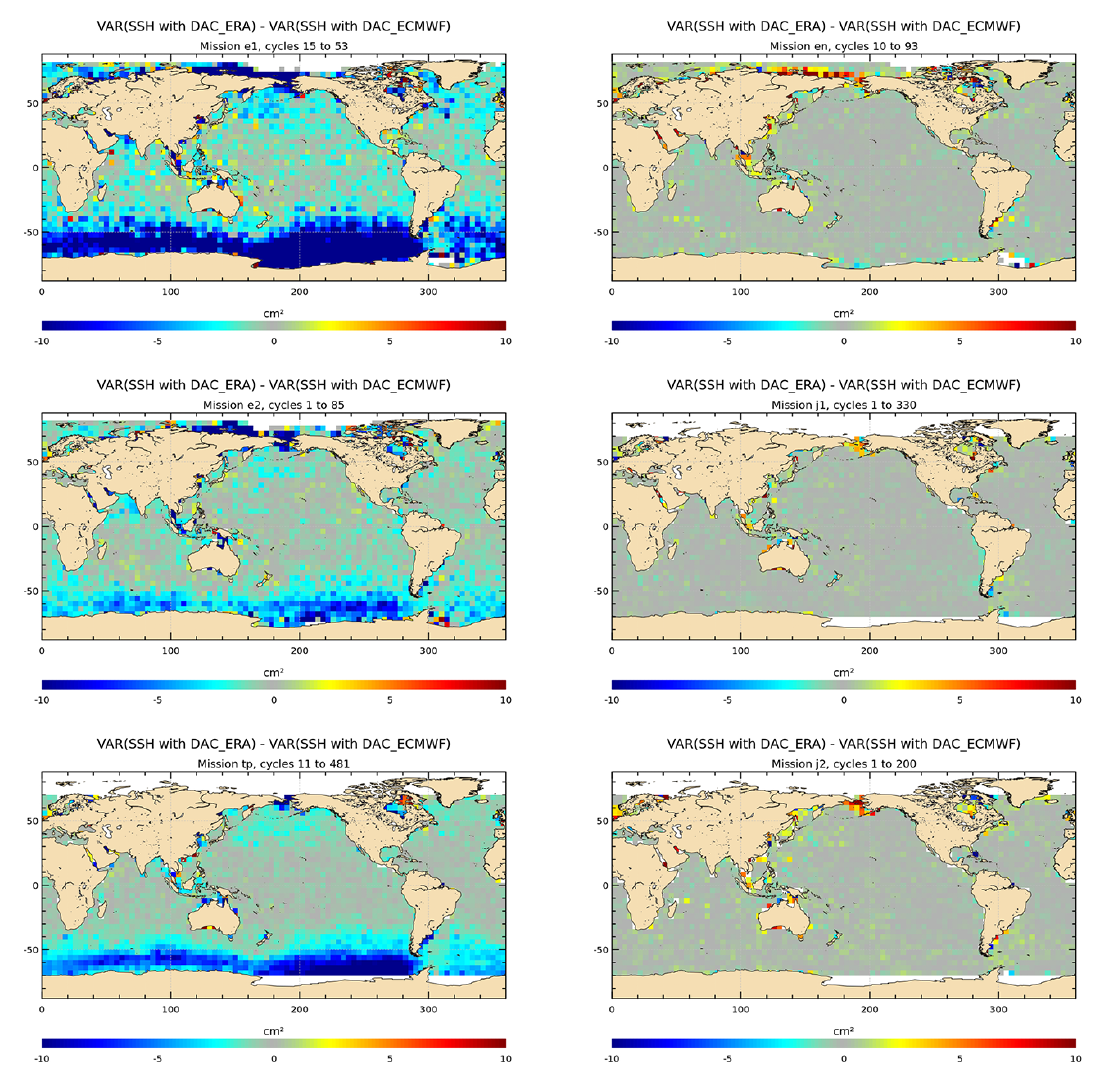
Figure 8. Maps of SSH variance differences at crossovers successively using the ERA-Interim and reference DAC solutions in the SSH calculation for ERS-1, ERS-2, and TP (on the left), and for Envisat, J1, and J2 (on the right) (cm 2